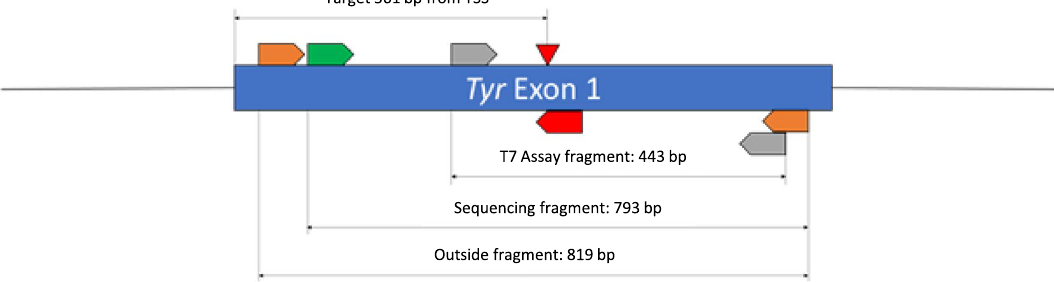
Figure 4. Target and PCR primer schematic. Red elements show gRNA and cut site position. Orange, grey and green elements show nested PCR primer